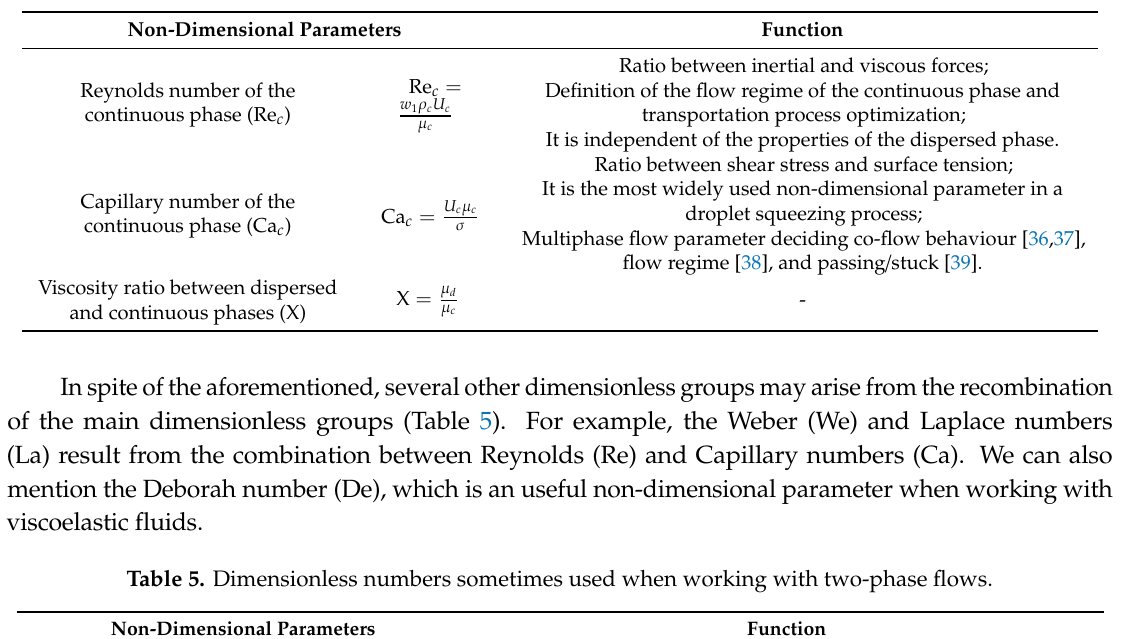
Table 4. Main dimensionless numbers that governs two-phase flows in microscale.